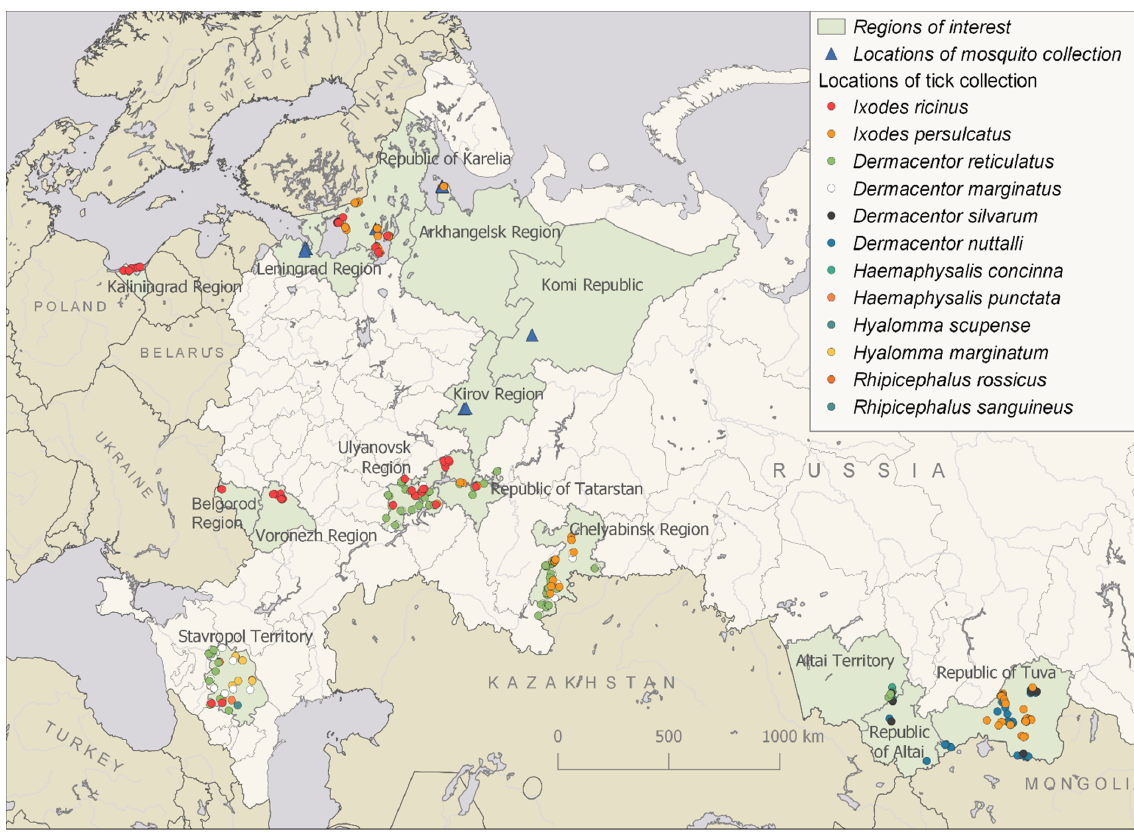
Figure 1. Locations of tick and mosquito collections in different regions of Russia.